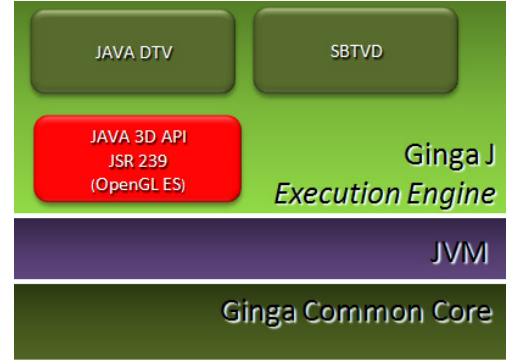
Figure 4. Sub-module renderer and others components of Native3D module.